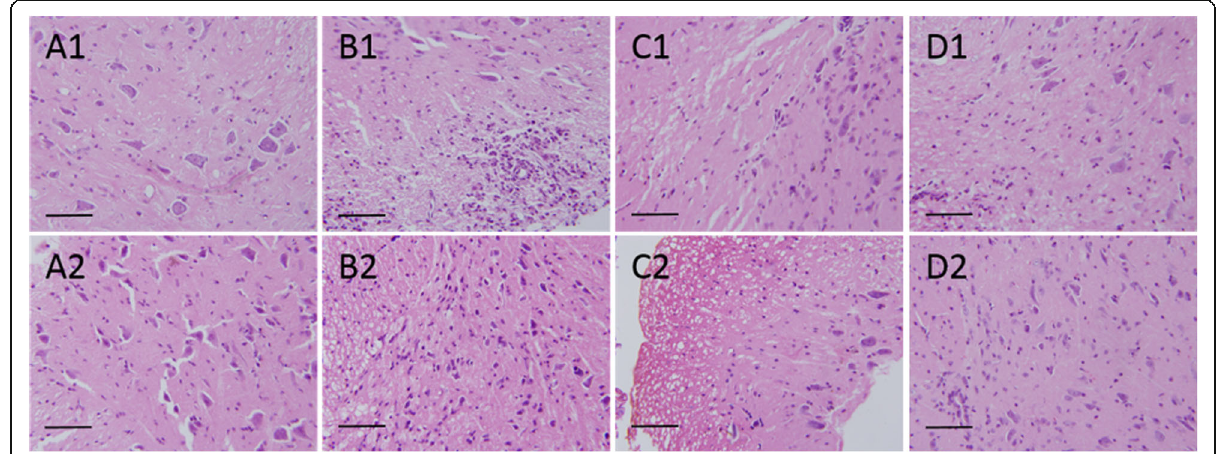
Fig. 3 Observation of pathological changes in the spinal cord of mice under the light microscope with H&E staining. A1 to D1 and A2 to D2 show the pathological changes in the spinal cord of mice on Day 18 and Day 40 in NC ( n =4), EAE ( n =4), EAE+ PA ( n =4), EAE+Catalpol – M ( n =4) mice, respectively (scale bar 20 μ